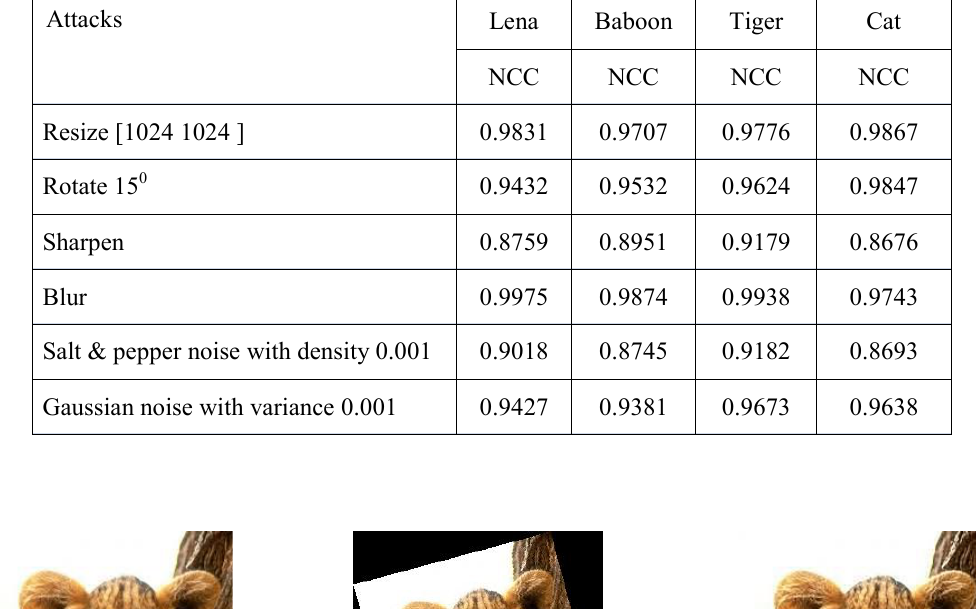
Table 2. NCC values of extracted secret image from stego images subjected to various